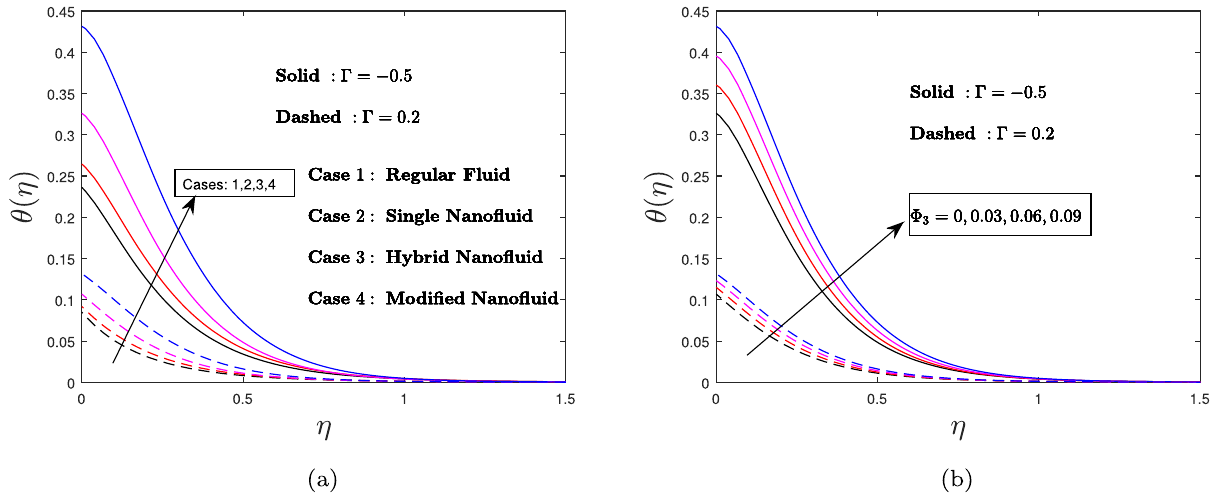
Figure 7: Behaviour of ( a ) regular fl uid, SNF, HNF, MNF, and ( b ) Φ 3 on thermal fi